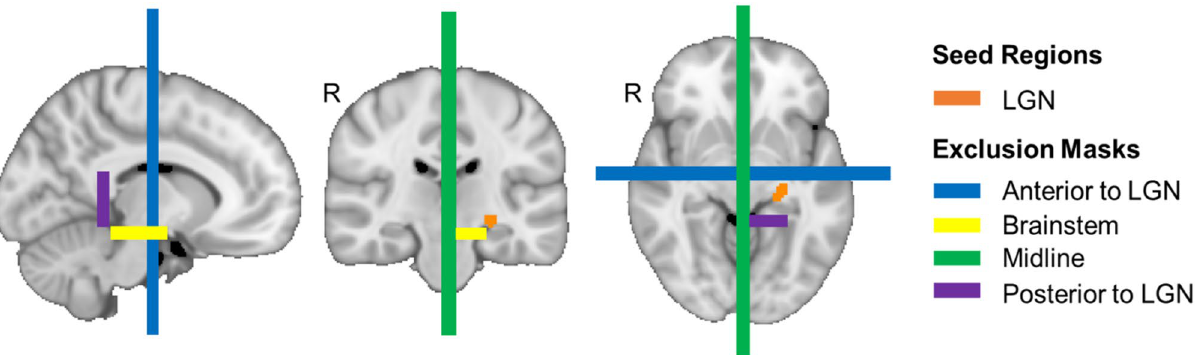
Figure 2. Example exclusion points and seed regions for the left optic radiations overlaid on the MNI152_1mm standard brain 37 . The lateral geniculate nucleus (LGN) was our seed region in each hemisphere (left shown in orange). Our exclusion masks included: a region anterior to the LGN to avoid longitudinal fibers being included (blue), the brainstem (yellow), the midline (green) and a region posterior to the LGN (purple) to help capture the curvature of the optic radiations close to the LGN. Exclusion points were the mirrored along the midline for the right hemisphere for the LGN, posterior point (purple) and brainstem points